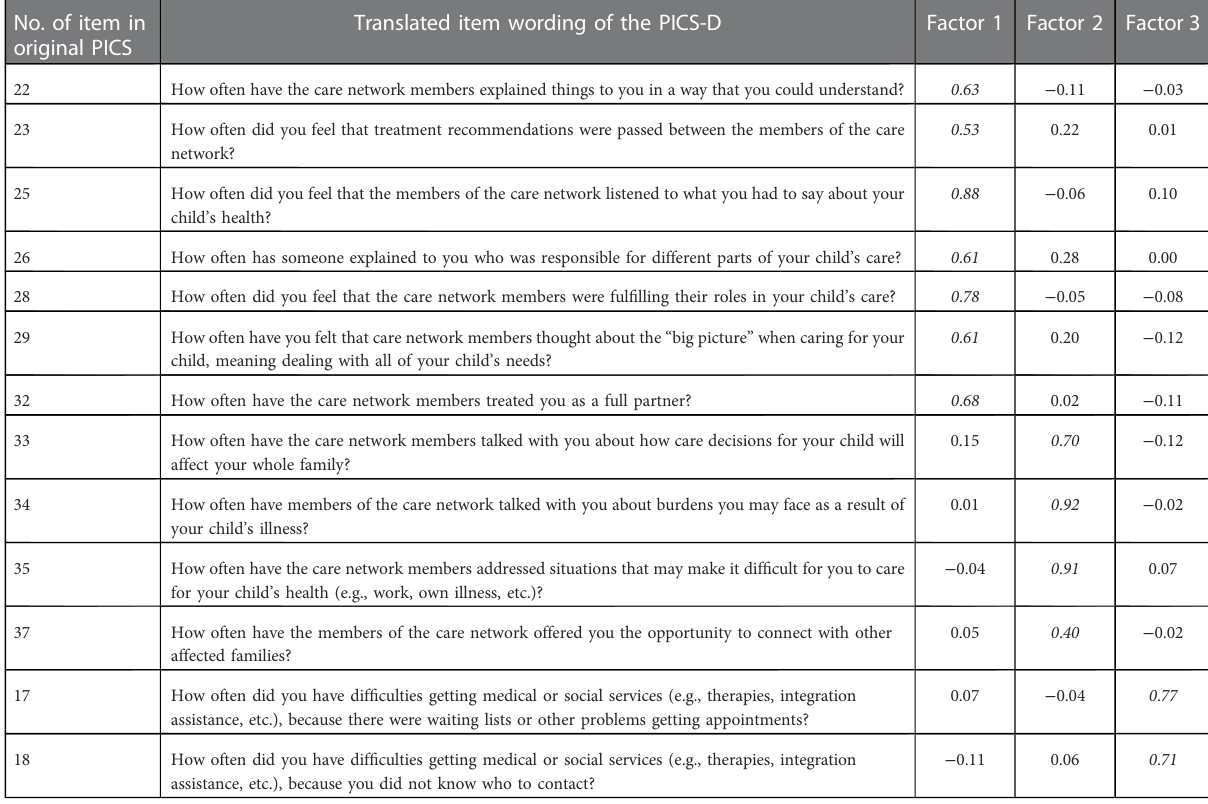
Translated item wording of the